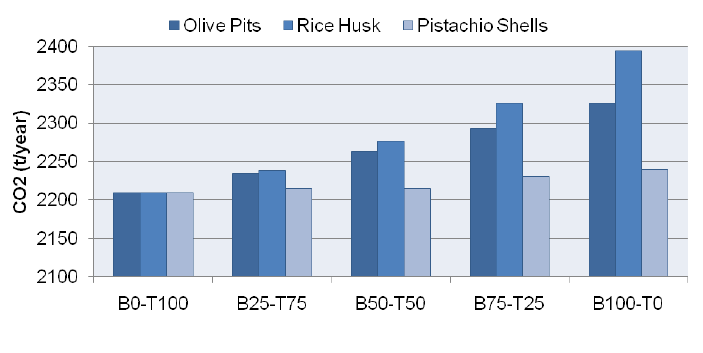
Fig. 4. Variation of the CO 2 emission of the system with different blends of Tunçbilek coal and biomass types.